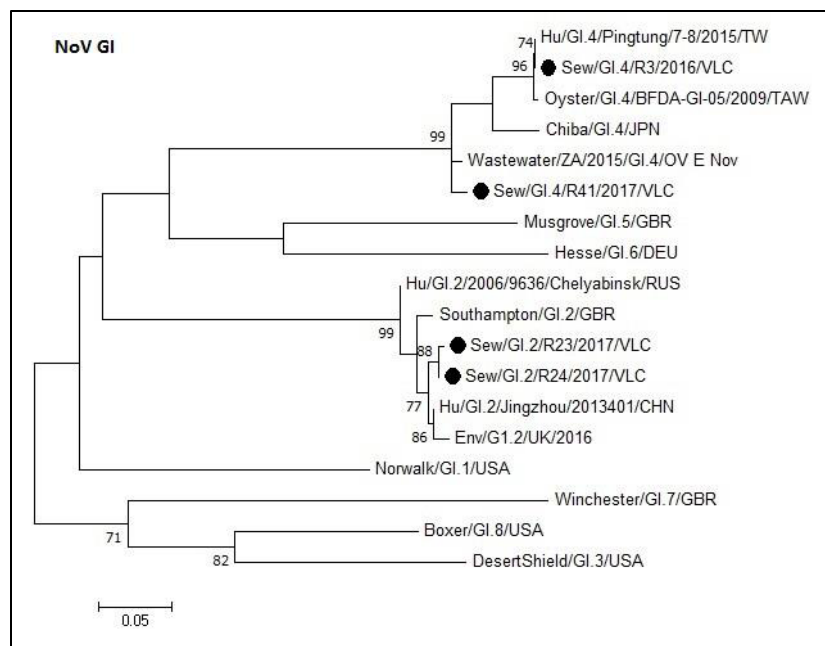
Figure 2. Molecular phylogenetic analysis of norovirus GI capsid. The evolutionary history was inferred using the Maximum Likelihood method based on the Kimura 2-parameter model [42] with a bootstrap of 1000 replicates. The tree is drawn to scale, the branch lengths measure the number of substitutions per site. The analysis included 18 nucleotide sequences. There were 276 positions in the final dataset including nucleotides from 5386 to 5662.